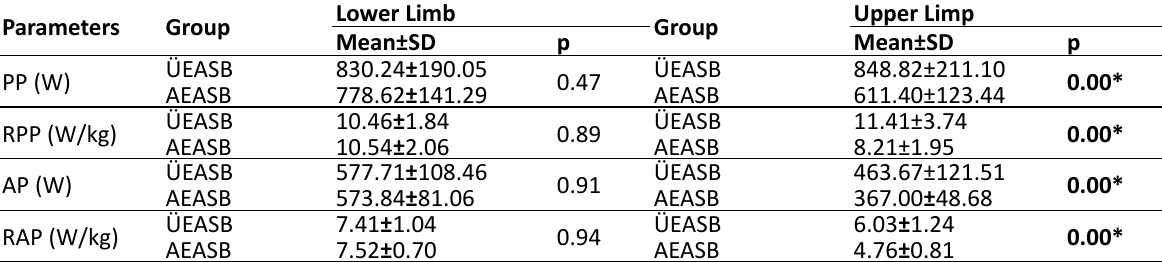
Table 5. Wingate test results of the participants in terms of extremity dominancy Parameters